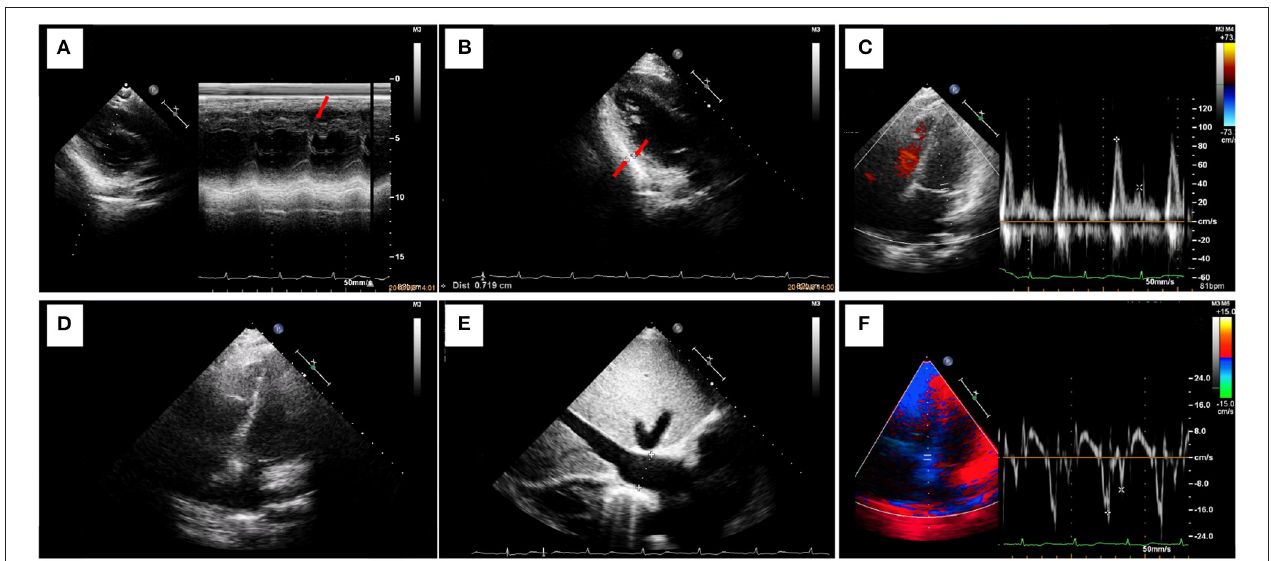
FIGURE 2 | Ultrasonography shows decreased cardiac function underlying protein-losing enteropathy. (A) M-mode ultrasonography shows thickening of the posterior pericardium of the posterior wall of the left ventricle and signs of a septal notch. The left ventricular ejection fraction is 77%. (B) The posterior pericardium of the posterior wall of the left ventricle is thickened (thickness, 7mm). (C) Pulse Doppler shows limited ventricular diastolic activity. The high peak E and low peak A result in an E/A of > 2. (D) A four-chamber view of the heart shows marked thickening of the pericardium and atrial enlargement. (E) The inferior vena cava is greatly widened (width, 26mm). (F) Myocardial relaxation is normal.